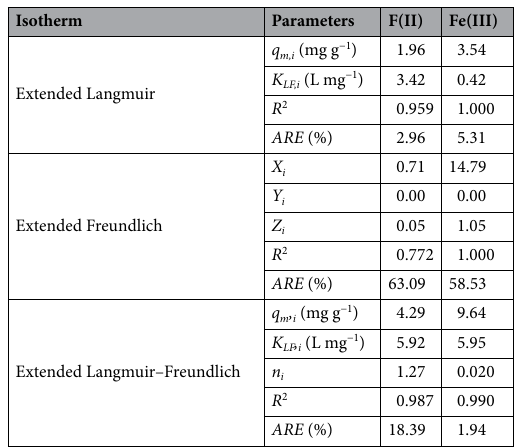
Table 5. Isotherm parameters for the adsorption of Fe(II) and Fe(III) from binary